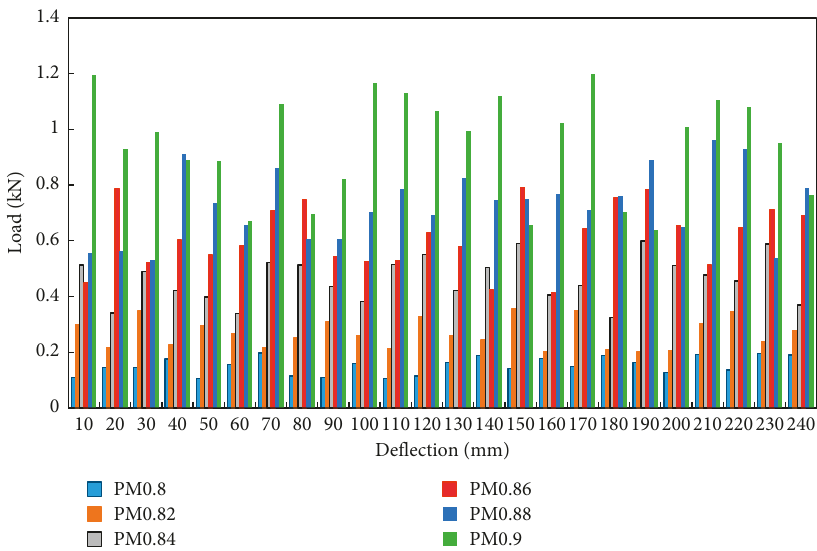
Figure 6: Test hydrogel performance by adding a small amount of SiO